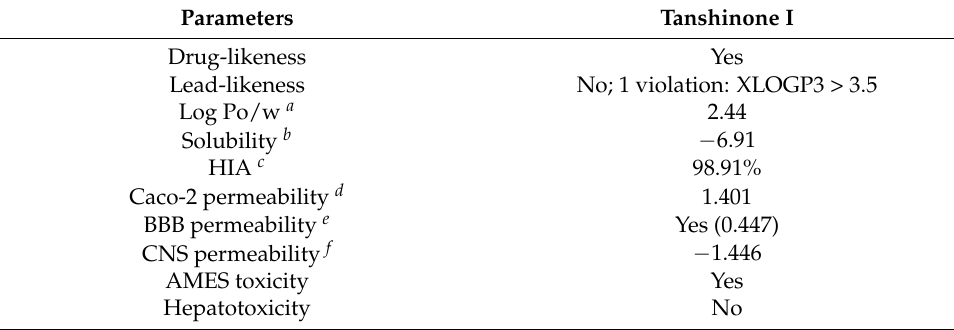
Table 4. Prediction of the pharmacokinetic parameters and toxicity of tanshinone